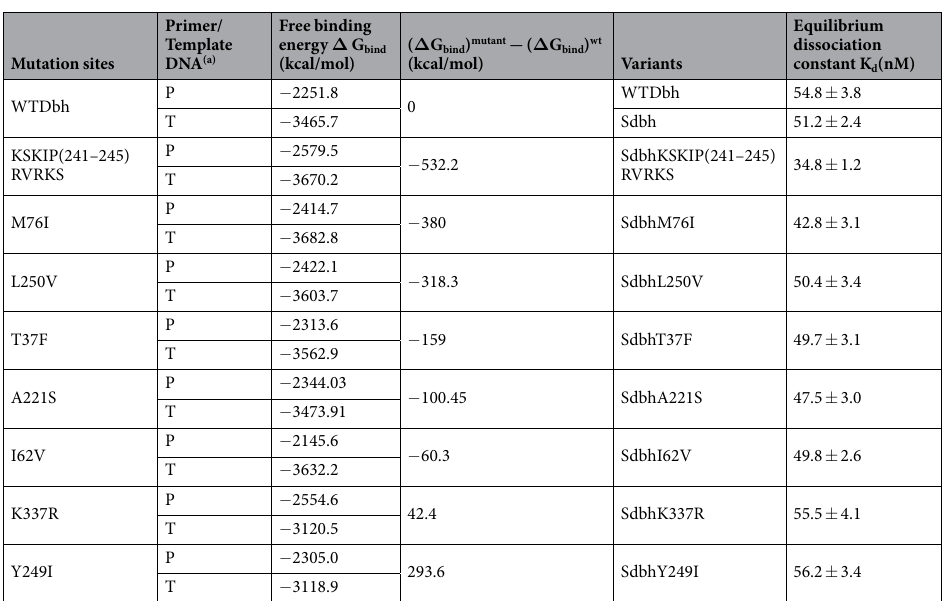
Table 2. Binding free energies and equilibrium dissociation constant of Dbh and the mutants to primer/ template DNA. (a) dsDNA (Primer/Template DNA) referred to the chain primer extended (P(5-3 ′ )) and the corresponding template chain (T(3 ′ -5 ′